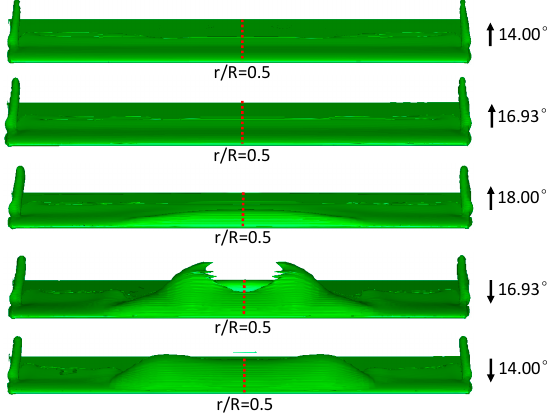
Figure 4. Equal vorticity surfaces at different angles of attack (AoAs).